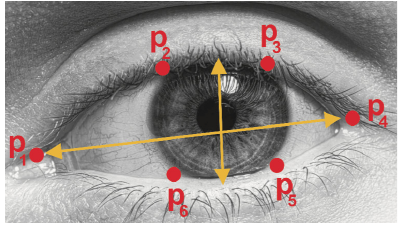
Figure 3. Example of 6 facial landmarks related to